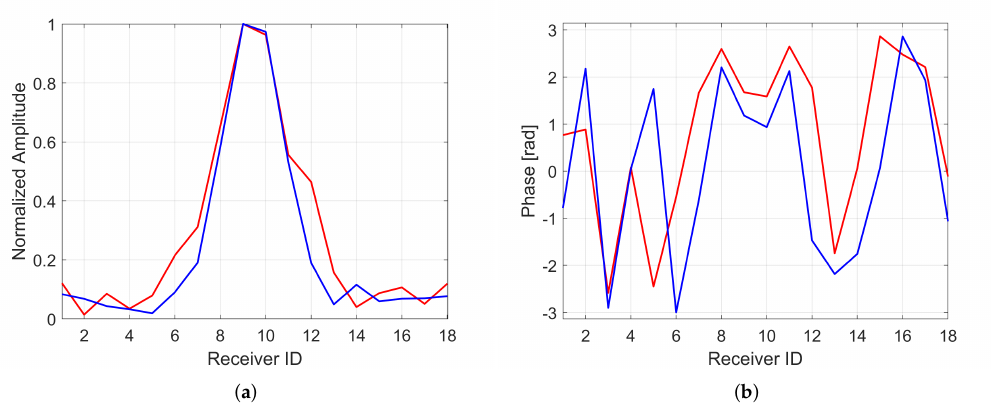
Figure 8. Scenario 4: three objects. ( a ) Picture of an acquisition and ( b ) its sketch in a two-dimensional plane.